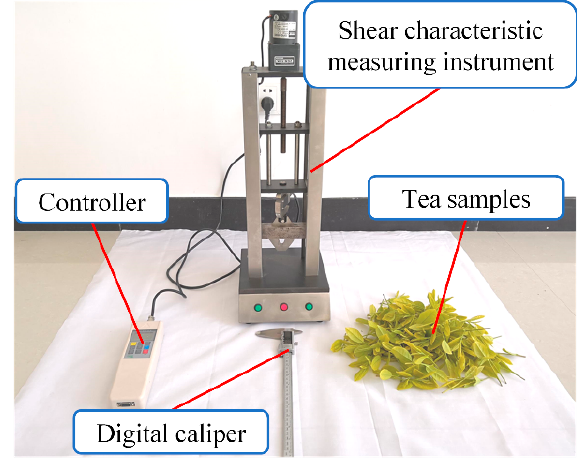
Figure 3. Measurement of the physical properties of tea.